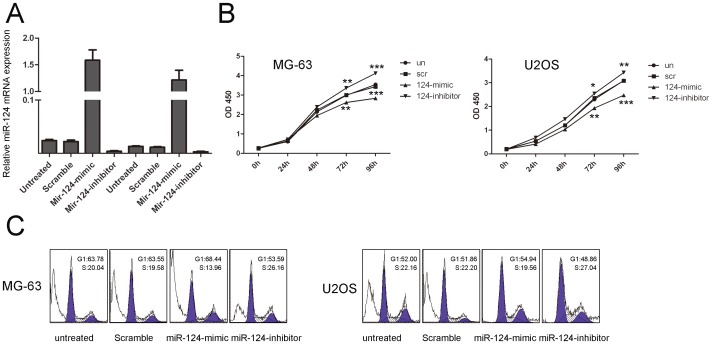
Overexpression of miR-124 inhibits osteosarcoma cell growth and affects cell cycle.(A) Expression levels of miR-124 were examined by real-time PCR after transfection of 50 nmol/L of miR-124 mimics or sramble or no transfection or miR-124 inhibitor. (B) Growth of MG-63 and U2OS cells were shown after transfection with 50 nmol/L of miR-10b mimics or sramble or no transfection or miR-124 inhibitor. The growth index as assessed at 0, 24, 48, 72, and 96 hours. (C)The effect of miR-124 on cell cycle progression of MG-63 and U2OS cells after 48-h incubation detected by flow cytometry analysis. Experiments were performed three times. Bars are mean±SD, *p<0.05, **p<0.01 and ***p<0.001.